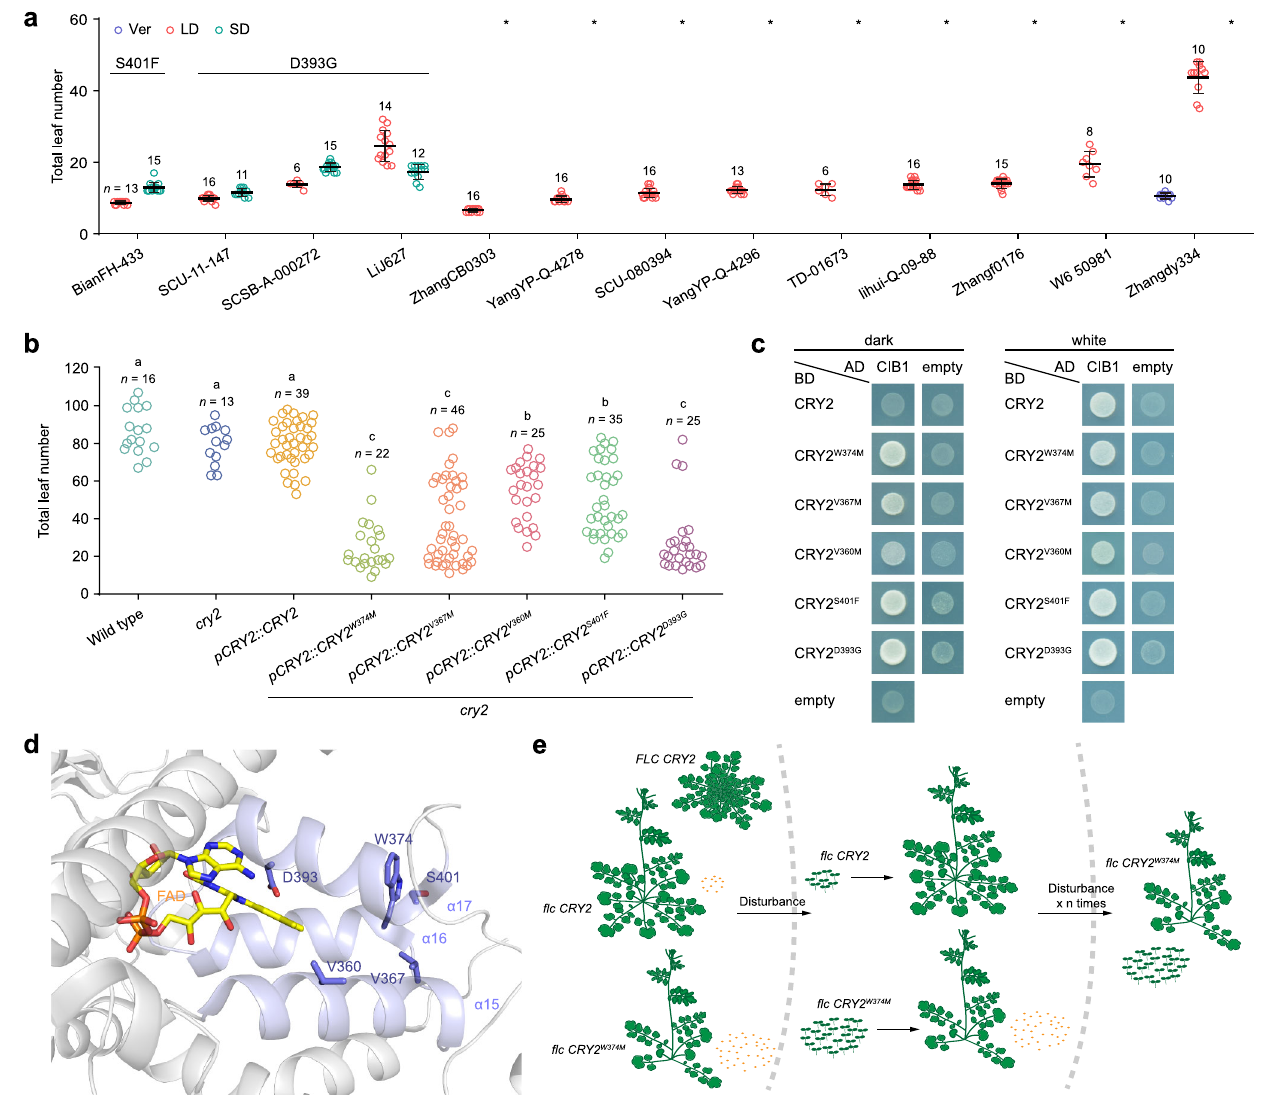
Fig.6|Dominantmutationsin CRY2 mightserveasacommongeneticbasisfor ruderalityinBrassicaceae.a Floweringtimeof R.palustris accessions.Plantswere grown under LD, SD, or vernalization conditions in a growth chamber. The total numberofleaveswhenplantsstartedtoboltwascounted.Asterisksindicateplants thatdidnot fl ower within1 year. The number of examinedplants ( n )isgiven. Error bars denote s.d. The centers of the error bars represent the mean values. b Flowering time of wild-type (Col-0), cry2 , and T 1 transgenic Arabidopsis lines. PlantsweregrowninagrowthchamberunderSDconditions.Thedifferentversions of CRY2 ( CRY2 W374M , CRY2 W367M , CRY2 V360M , CRY2 S401F , and CRY2 D393G ) were expressed from the Arabidopsis CRY2 promoter. The CRY2 W374M , CRY2 V367M , and CRY2 V360M hap- lotypes were identi fi ed in C. occulta accessions (Fig. 1c), whereas the CRY2 S401F and CRY2 D393G haplotypes were found in R. palustris accessions ( a ). Letters indicate